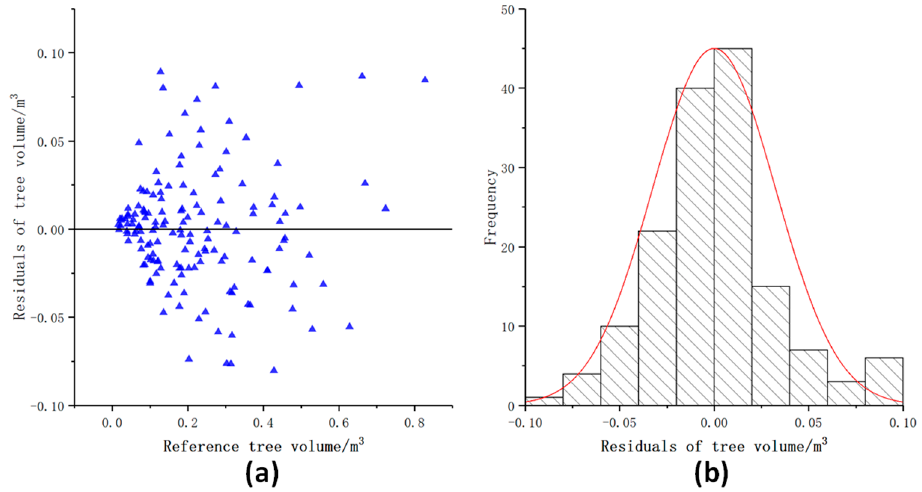
Figure 11. Distribution of the volume residuals. ( a ) Scatter distribution of tree volume residuals; ( b ) Histogram of tree volume residuals distribution.